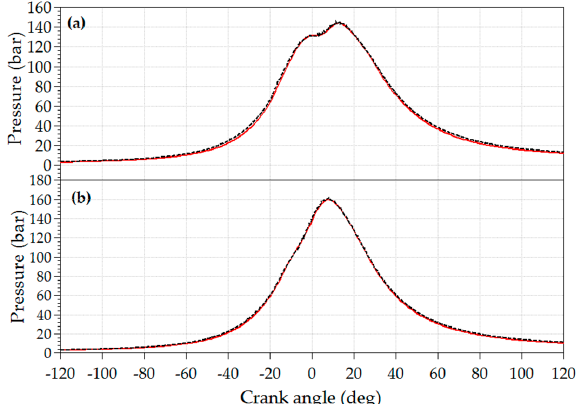
Figure 12. Simulated (sim) and measured (exp) cylinder pressure traces at part ‐ load steady ‐ state operating points: ( a ) 775 rpm and 0.24 bar BMEP; ( b ) 1600 rpm and 3.22 bar BMEP.